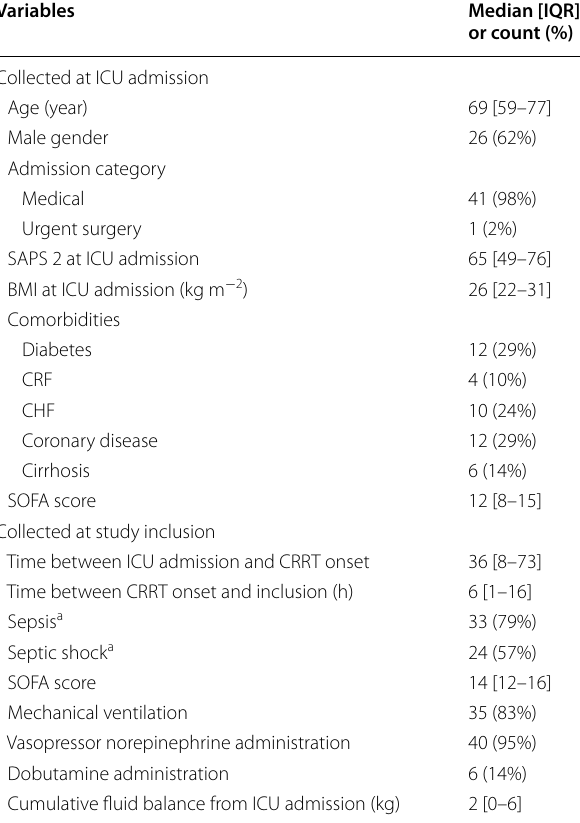
Table 1 Population characteristics at ICU admission and at study